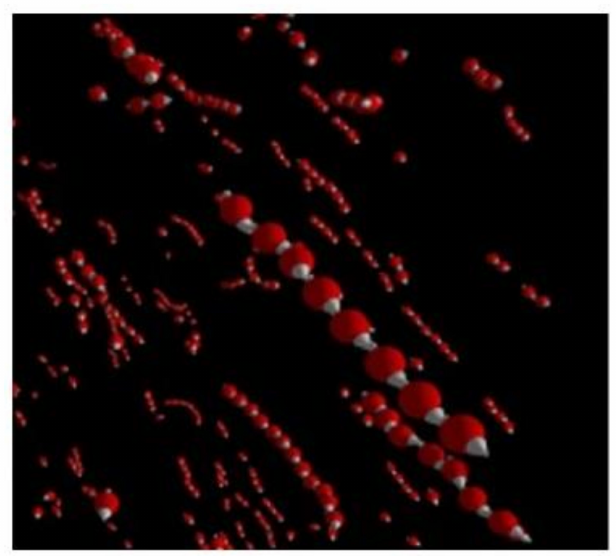
Figure 6. Particle structures obtained from Monte Carlo simulations that were used for calculating the pattern given in Figure 4. The mage was kindly provided by Patrick Ilg (University of Reading) and was obtained using the methods given in [66].